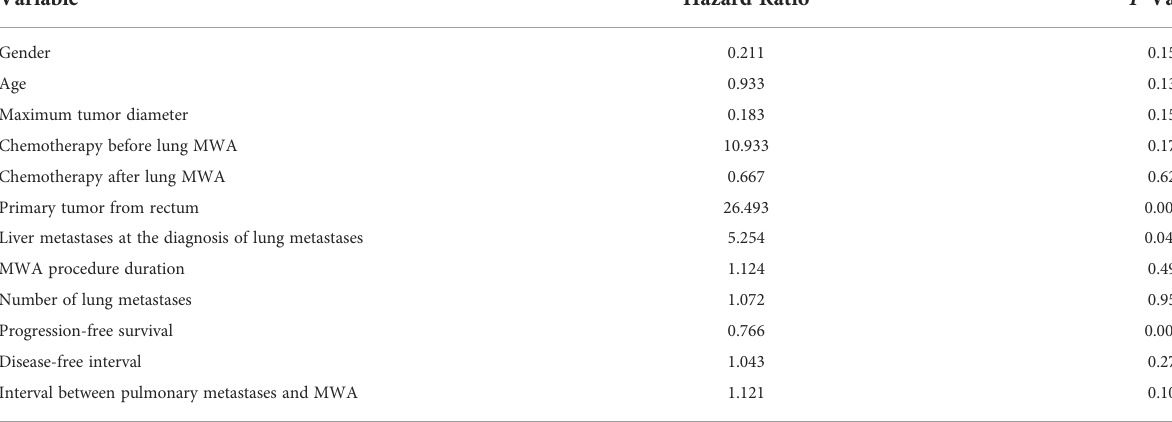
TABLE 5 Multivariable analyses of prognostic factors for overall survival.